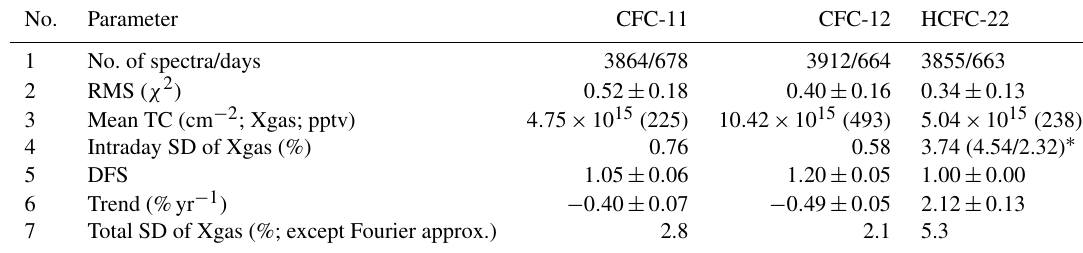
Table 3. Summary of the statistics for retrieved halocarbon TCs after filtering. No.